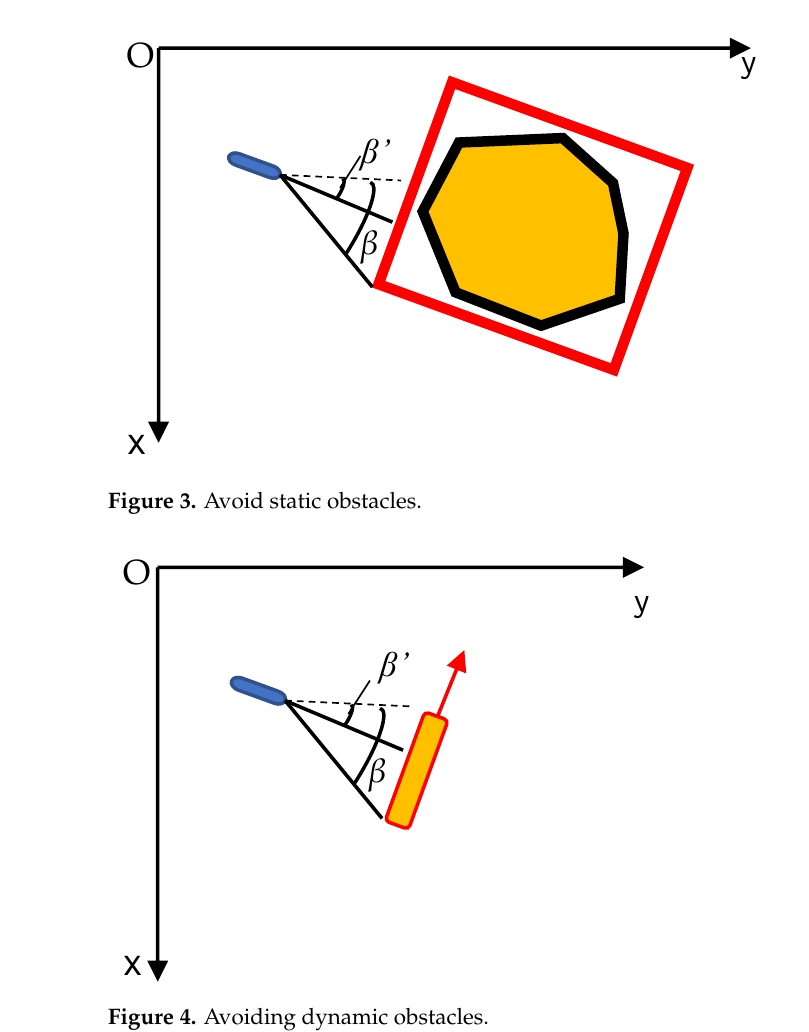
Figure 4. Avoiding dynamic obstacles.